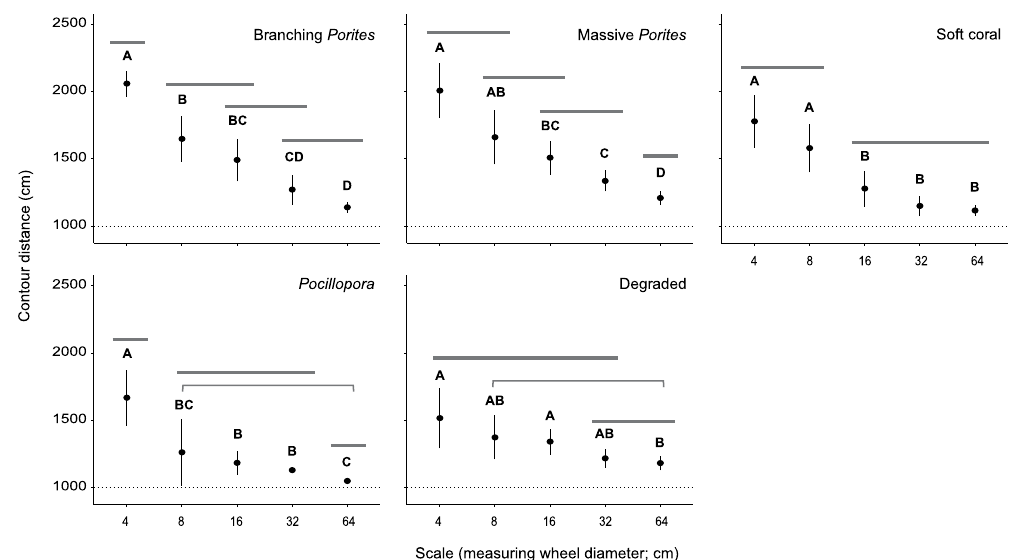
Figure 4. Modelled contour distance ( ± 95% confidence intervals) measured using wheels representing scales 4–64 cm (wheel diameters, cm: 3.99; 7.97; 15.95; 31.89; 63.79), within each habitat. Significant differences between habitats revealed by linear mixed effects modelling and post hoc Tukey pair-wise comparisons are illustrated by the pairing of letters (P < 0.05). Grey bars across scales further illustrate similarities in structural complexity across scales of measurement in each habitat. Thin grey bars in Pocillopora and Degraded habitats denote similarities in contour distance over scales at either end of the bar (i.e. non-consecutive